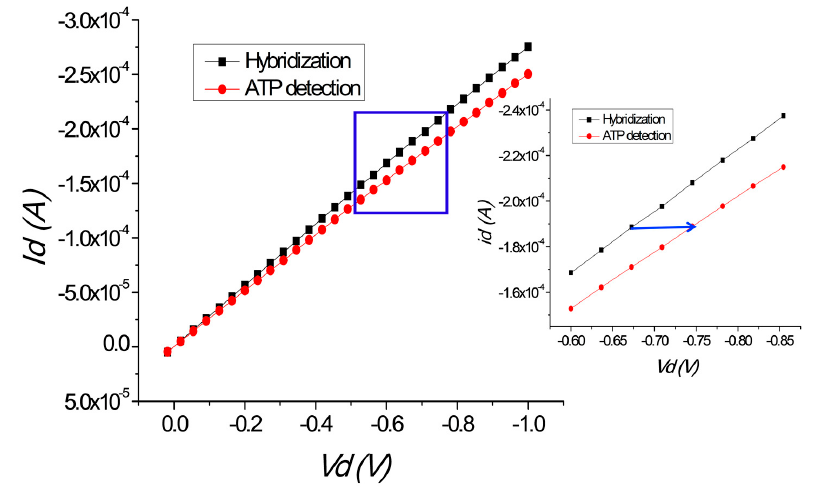
Figure 7. I – V (drain current I d and drain–source voltage V d ) characteristics of the modified diamond-based field-effect transistor (FET) showing ATP activity (gate voltage − 0.2 V).